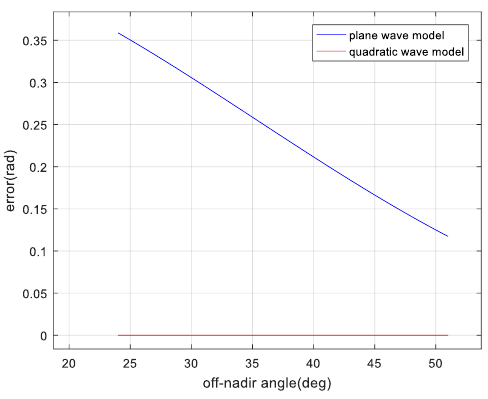
Figure 6. Phase errors of the plane wave model and quadratic wave model.